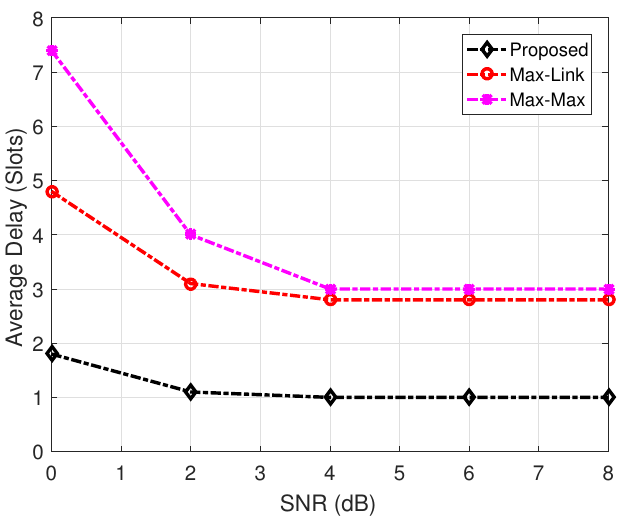
Figure 17. Average delay vs.